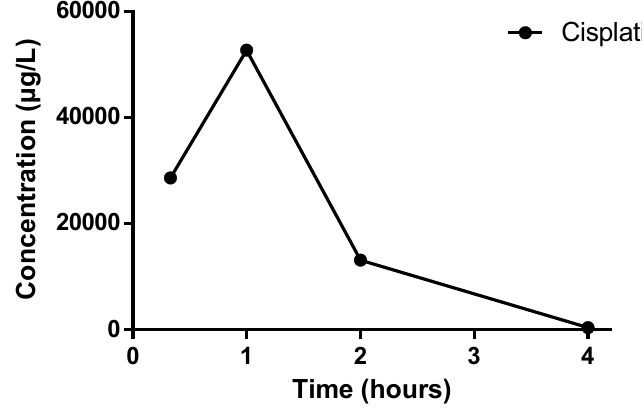
Figure 7. Time-concentration profile of cisplatin in plasma after a single administration via oral gavage at a dose of 300 mg/Kg body weight.